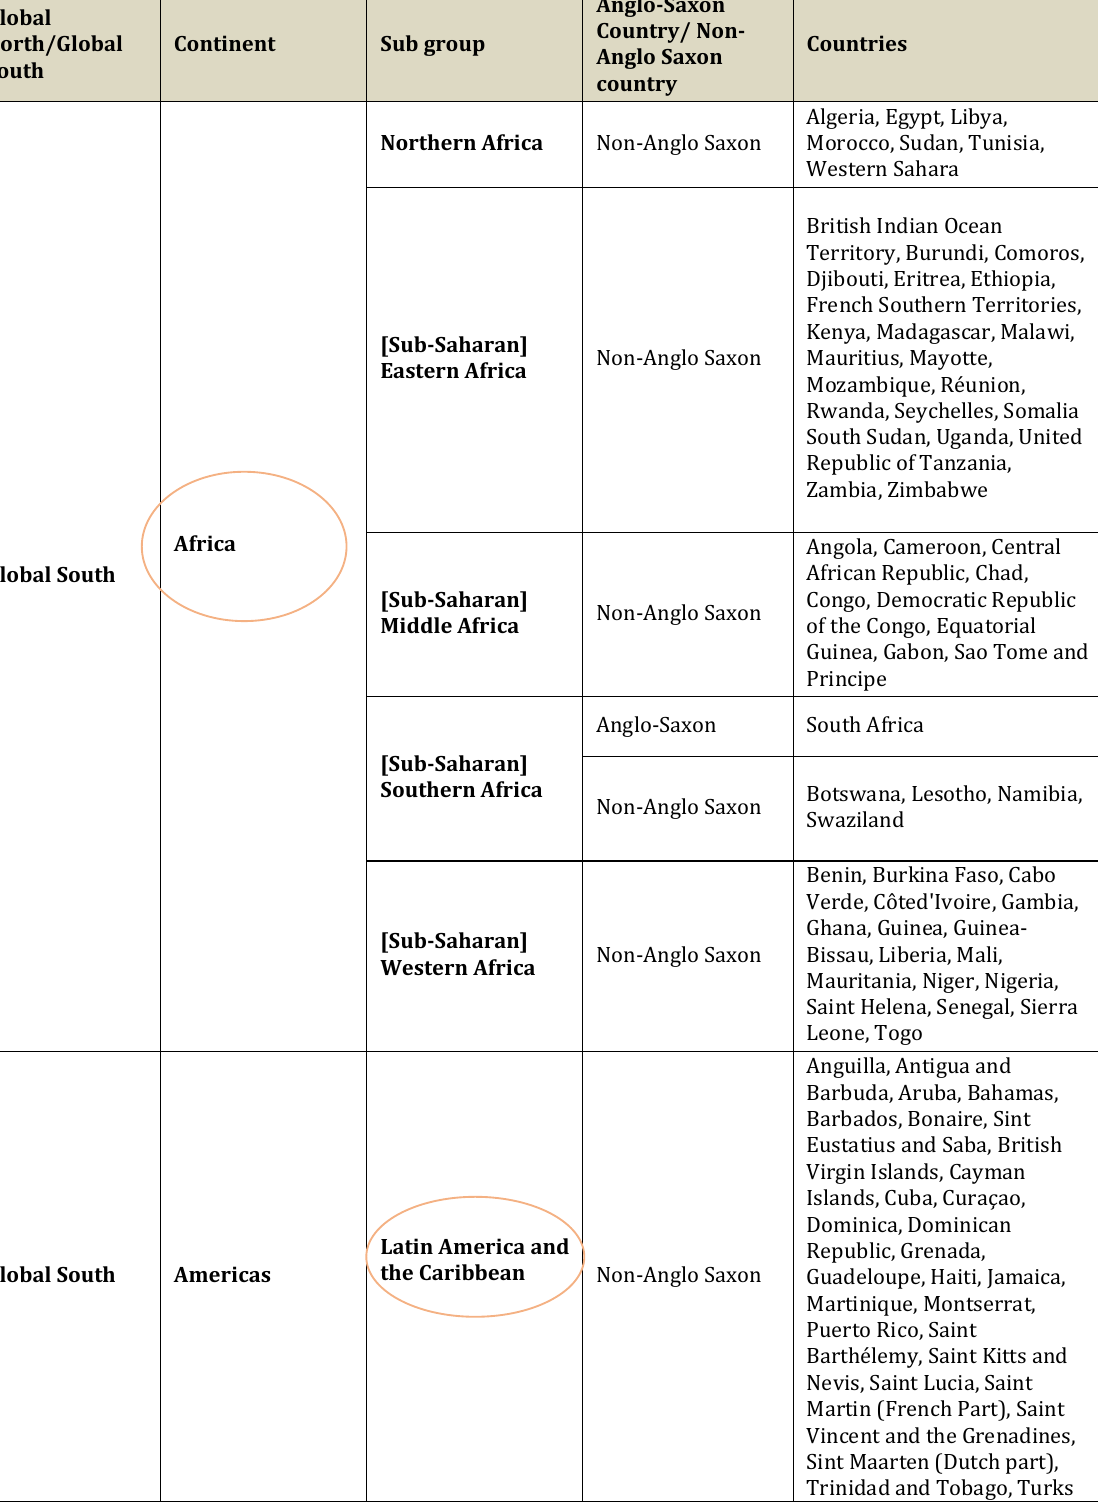
Table 8: Country grouping table into continents and global North/South Global